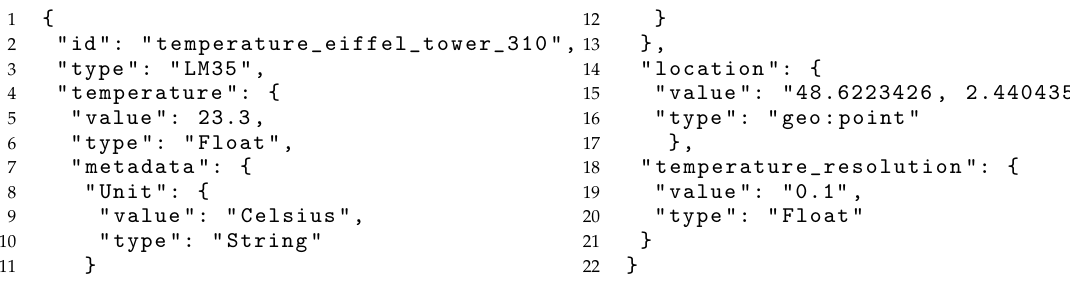
Listing 4. Representation of temperature sensor data in